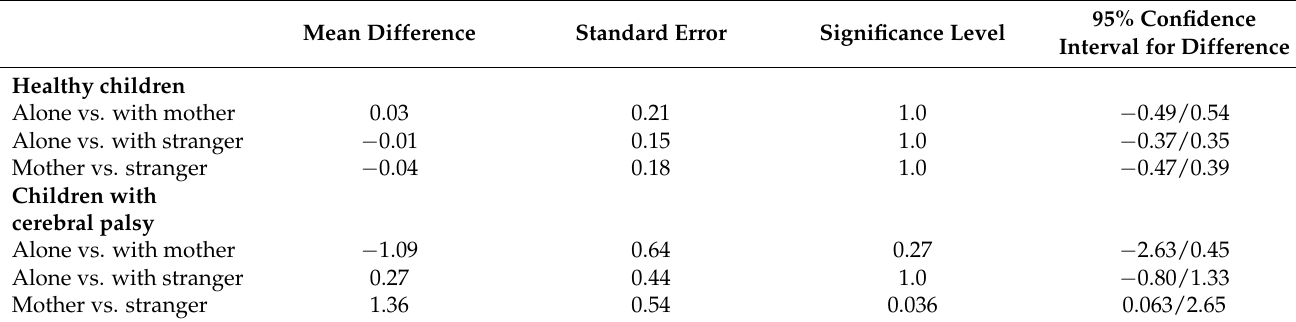
Table 3. Statistical pairwise comparisons of pressure pain thresholds for each social support situations (alone vs. with their mother vs. with a stranger) at each group (children with CP, healthy